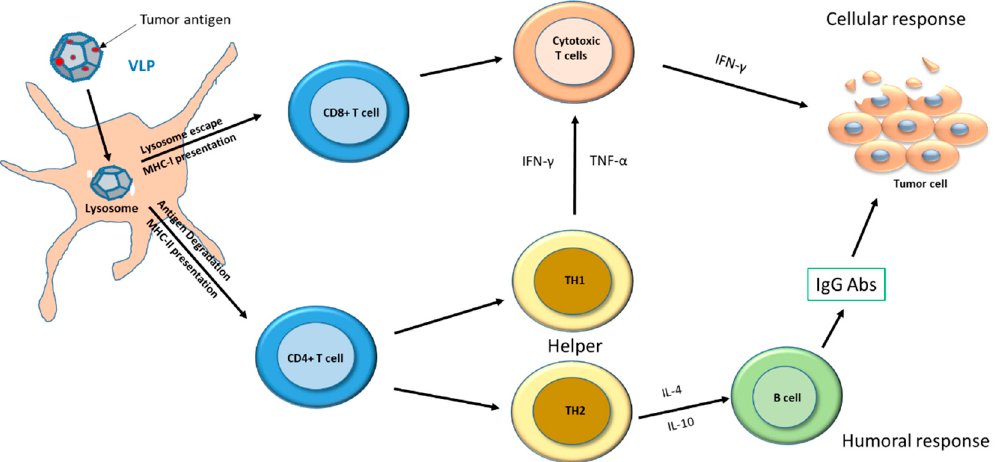
Figure 1. VLP-based vaccine: mechanism of action against tumor cells. VLPs are phagocytized and processed by DCs to present the tumor antigen on MHC-I and MHC-II for recognition by CD8 + and CD4 + T cells. CD4 + T cells differentiate into TH2 and TH1 cells that are involved in inflammatory response and in sustaining the activity of CD8 + T cells (cytotoxic T cells), respectively. CD8 + T cells exert cytotoxic activity on tumor cells.